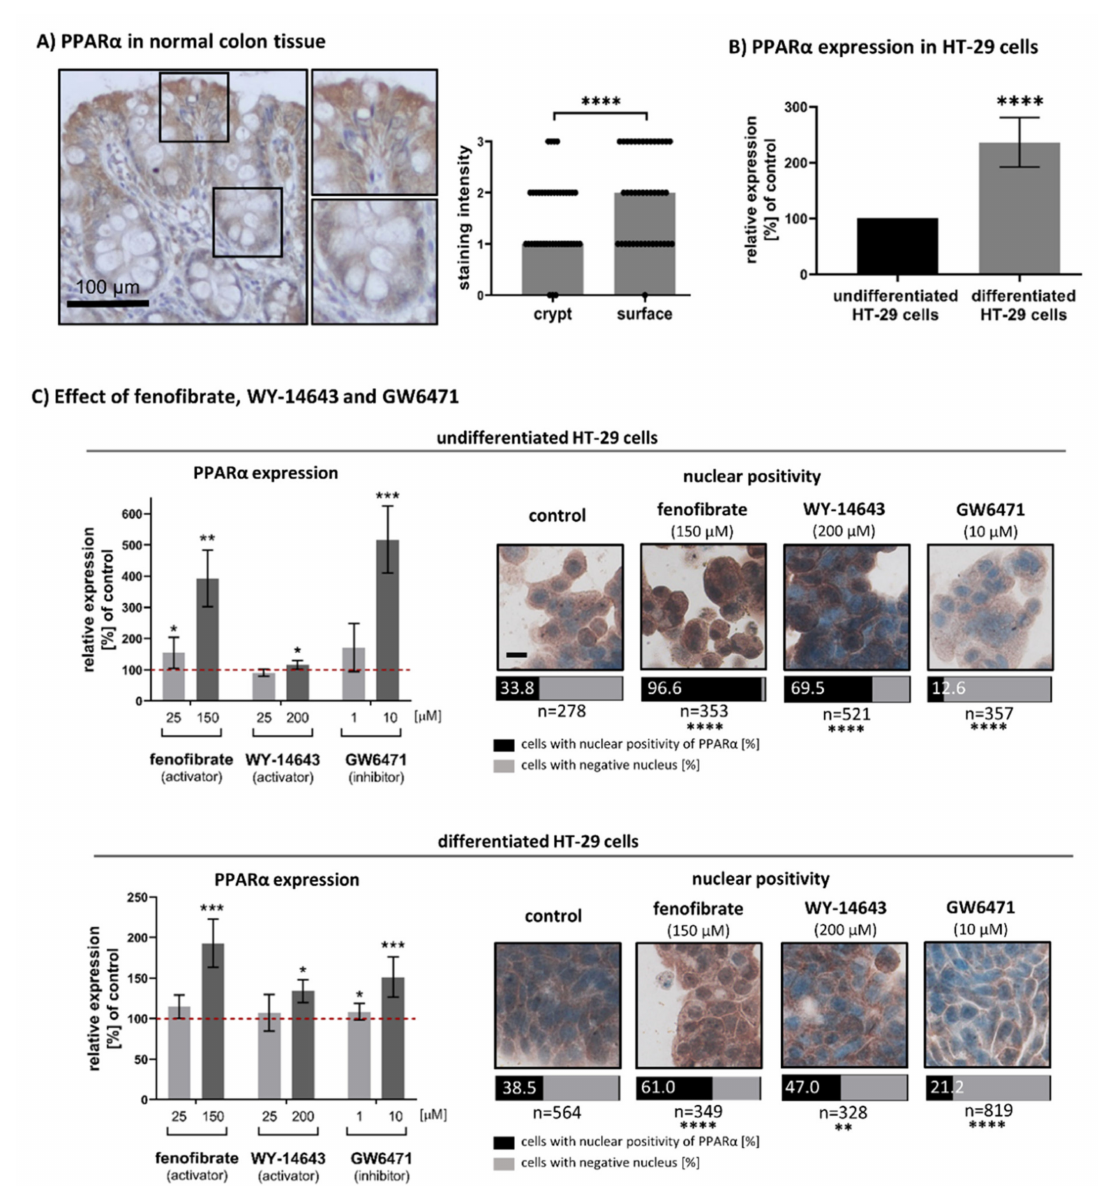
Figure 1. Expression and nuclear localisation of PPAR α in undifferentiated and differentiated intestinal cells: ( A ) Com- parison of immunostaining intensity in crypt area (undifferentiated cells) and surface epithelium (differentiated cells). The immunohistochemical (IHC) profile is shown as medians of staining intensities of all samples. Staining intensities were evaluated semi-quantitatively: negative (0), weak (1), moderate (2) and strong (3). The results were evaluated by Wilcox test, n = 37. Magnification 200x, details 400x, antibody signal brown, nuclei blue. ( B ) Relative change of PPAR α expression between undifferentiated and differentiated HT-29 cells measured by In Cell-ELISA. Black columns represent controls, undifferentiated or differentiated cells (100%). Results are shown as mean ± SD ( n = 6) and evaluated by one sample t -test. ( C ) Effect of PPAR α activators (fenofibrate and WY-14643) and PPAR α inhibitor (GW6471) on PPAR α expression and subcellular localisation in HT-29 cells. Relative expression of PPAR α in comparison to control was measured by In-Cell ELISA. Results are shown as the mean ± SD ( n = 6) and evaluated by one-sample t -test. The red dotted lines represent control cells: DMSO treated undifferentiated or differentiated cells (100%). Nuclear positivity of PPAR α was evaluated as the % of cells with nuclear PPAR α positivity from 5 fields of vision. The results were evaluated by Fisher’s exact test. Fenofibrate and WY-14643 favoured nuclear positivity of PPAR α , whereas GW6471 retained PPAR α in cell cytoplasm. All microphotographs are in the same magnification (400x); the black line represents 10 µ m; brown - antibody signal; blue -nuclei. Statistically significant results in comparison to control cells are marked directly in the graphs: * p ≤ 0.05, ** p ≤ 0.01, *** p ≤ 0.001, **** p ≤